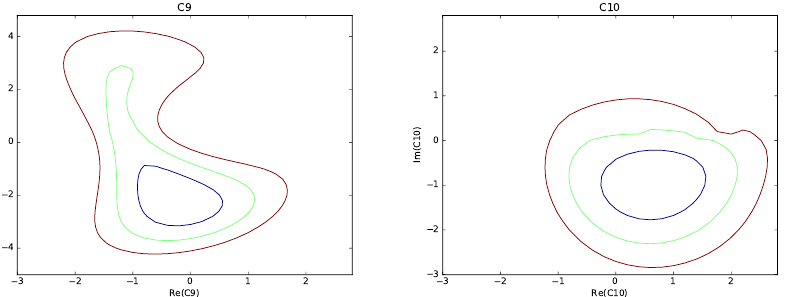
Figure 5 . Contour plots for real and imaginary part of (cid:14)C 9 (left) and (cid:14)C 10 (right) when both coe(cid:14)cients are allowed to di(cid:11)er from zero. The (cid:31) 2 at each point of the plane is minimised with respect to the remaining two